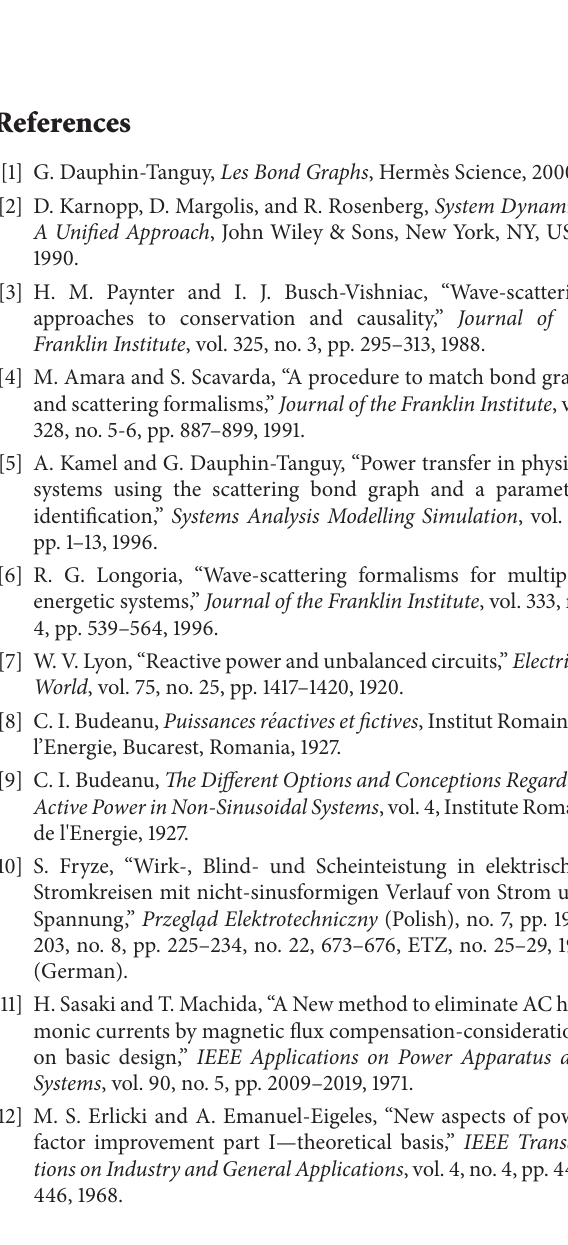
Figure 19: Losses power in the StBG of Figure